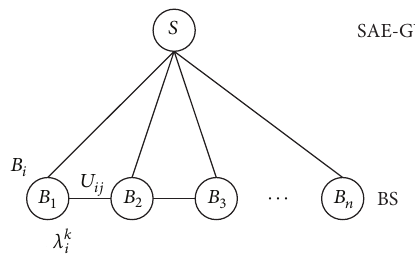
Figure 2: Direct coordinated edge caching